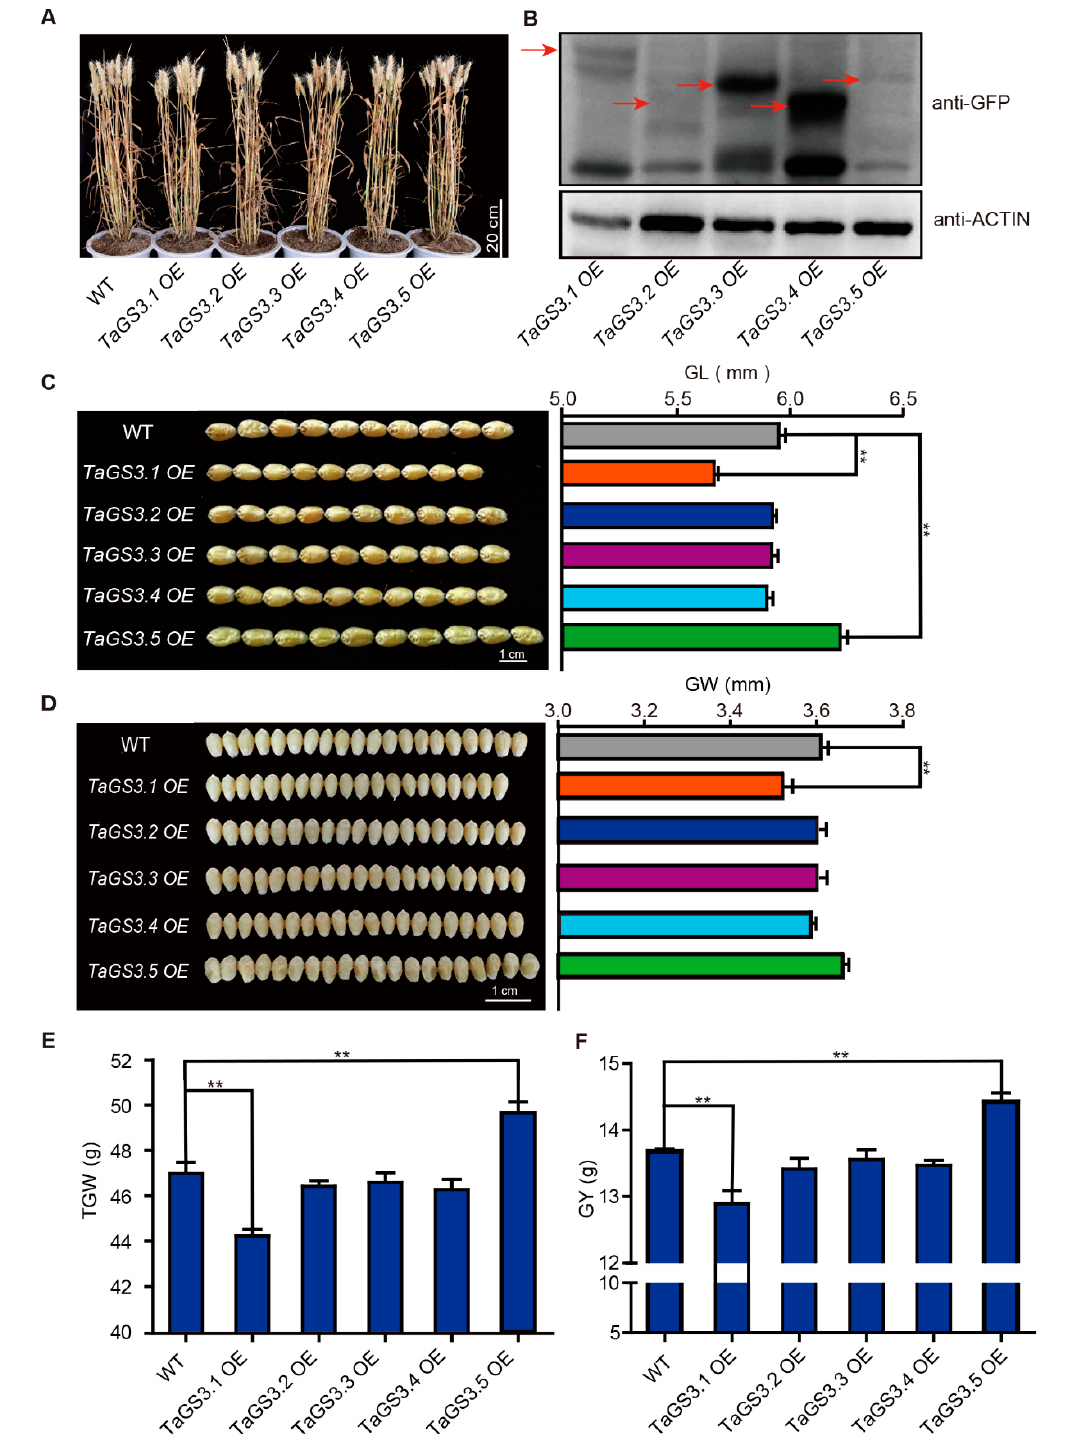
Figure 4. Phenotypic comparison of agronomic attributes among the overexpression lines of TaGS3 splicing variants and WT under field conditions. ( A ) Overview of the whole plants of TaGS3 splicing variants overexpression lines and WT. Bar = 20 cm. ( B ) Immunoblot analysis of the T 3 transgenic plants of TaGS3 splicing variants. Total protein was extracted from the leaves of 3-day-old seedlings for Western blotting. ( C ) Comparison of the grain length among the tested genotypes. Bar = 1 cm. ( D ) Comparison of the grain width among the tested genotypes. Bar = 1 cm. ( E ) Thousand-grain weight (TGW) and ( F ) grain yield per plant (GY) of the tested genotypes. ** p < 0.01 (Tukey test) indicates significant differences between the overexpression lines and WT. Data are given as mean ± SEM (n = 10).